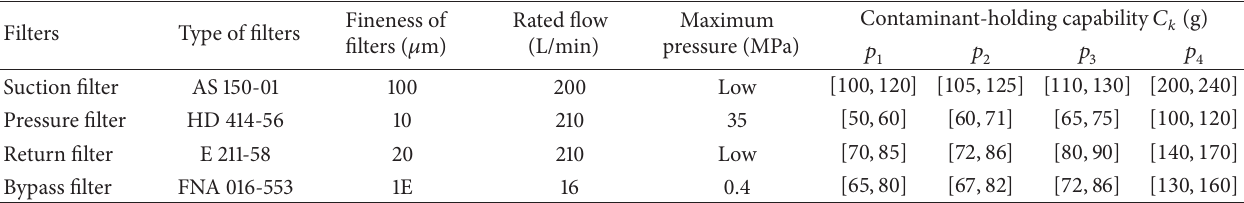
Table 3: Type and performance parameters of filters.